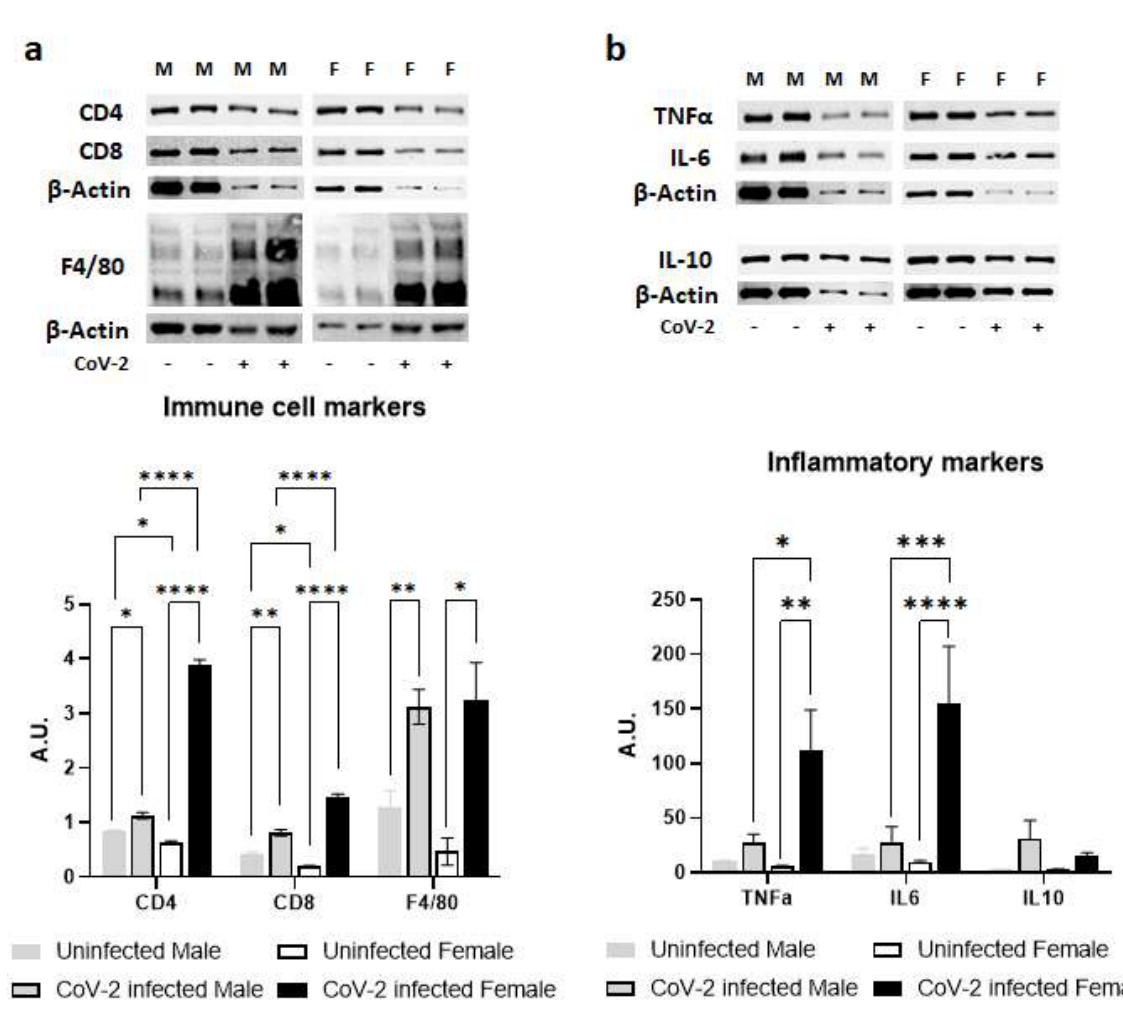
Figure 3. Immune signaling in the WAT during CoV-2 infection is altered differently between the sexes. Immunoblot images of ( a ) immune cell markers (CD4, CD8, F4/80) and ( b ) inflammatory markers (TNF α , IL-6, IL-10). β -actin was used as loading control. Fold changes in the protein levels were normalized to β -actin expression and are shown as bar graphs. The error bars represent standard error of the mean. * p < 0.05, ** p < 0.01, *** p < 0.001, and **** p < 0.0001 compared to uninfected sex-matched mice and between the infected groups ( n = 4/sex/group) (M, male; F, female).